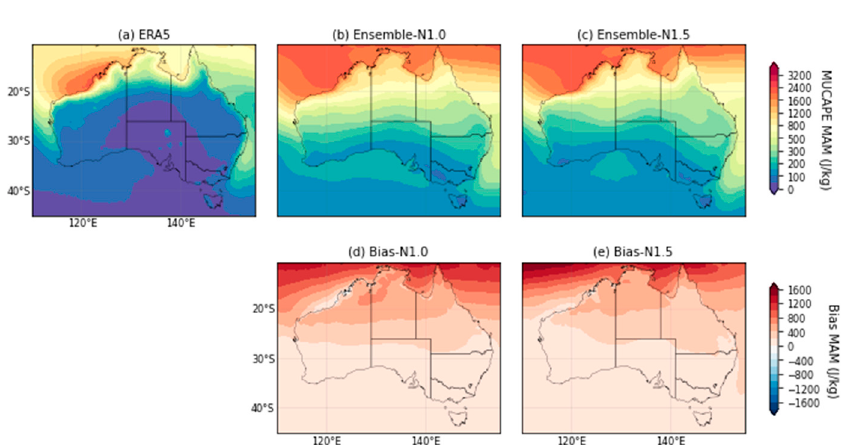
Figure A4. As in Figure A3 except for DJF.